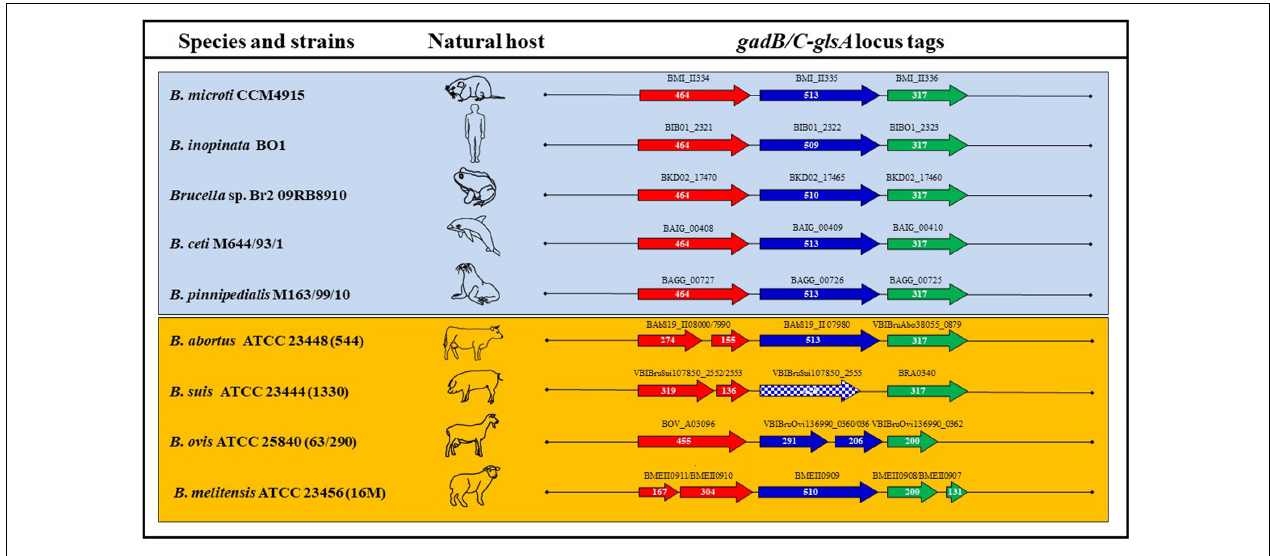
FIGURE 5 | Schematic representation of the ORFs composing the gadB/C – glsA locus of representative Brucella species and strains. Each arrow length is proportional to the gene length, whereas the distance between two consecutive genes is not as precise, though reflecting the approximate distance between them. The corresponding locus tags are shown above each arrow. Squared arrows mark genes shorter than the canonical length of B. microti CCM4915. The host where each strain was first isolated is represented by a schematic picture.